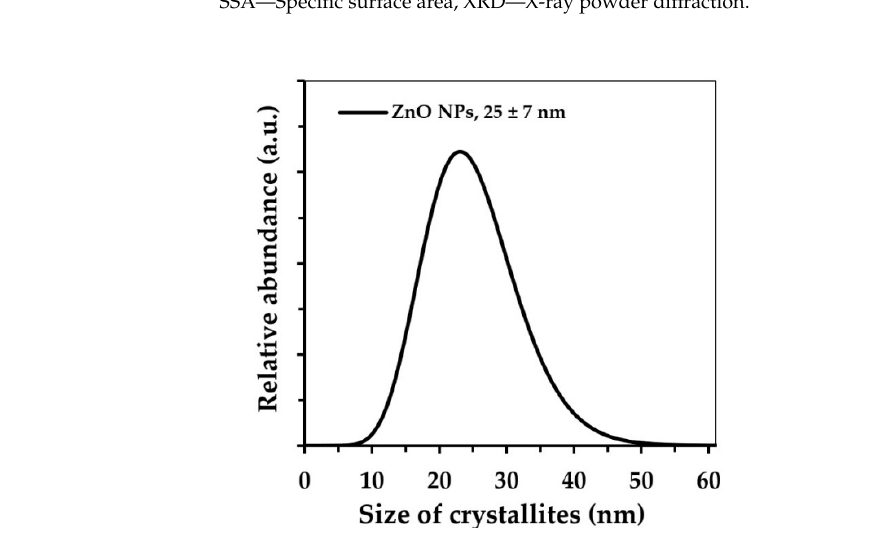
Figure 3. Crystallite size distributions of ZnO NPs.